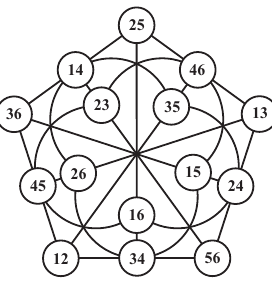
Figure 7. A duad-syntheme model of W ( 3,2 )